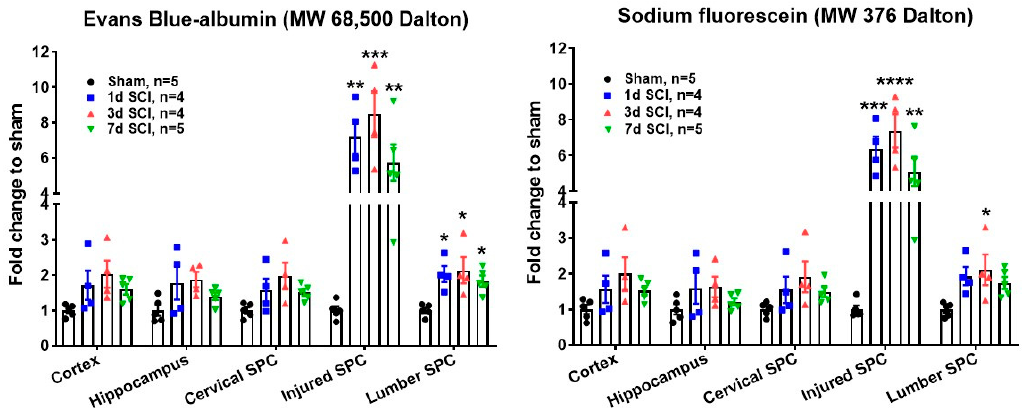
Figure 1. Blood–brain barrier (BBB) and blood–spinal cord barrier (BSB) permeability assay. A T10 spinal cord contusion injury (moderate / severe injury) was produced in young adult C57BL / 6 male mice (2–3 months old) using the Infinite Horizon spinal cord impactor as previously described [38,40] [158,190]. 100 μ L of saline solution containing 10% sodium fluorescein and 2% Evans blue was injected by tail vein (100 μ L/mouse) at 1 d, 3 d, and 7 d after SCI. At 30 min after dye injection, mice were perfused with 100 mL of saline and injured thoracic spinal cord (SPC), lumbar and cervical SPC, as well as cerebral cortex and hippocampus were dissected for fluorescent assay (sodium fluorescein at 485 / 528 nm, Evans blue at 470 / 680 nm). * p < 0.05, ** p < 0.01, *** p < 0.001, **** p < 0.0001 vs. Sham. One-way